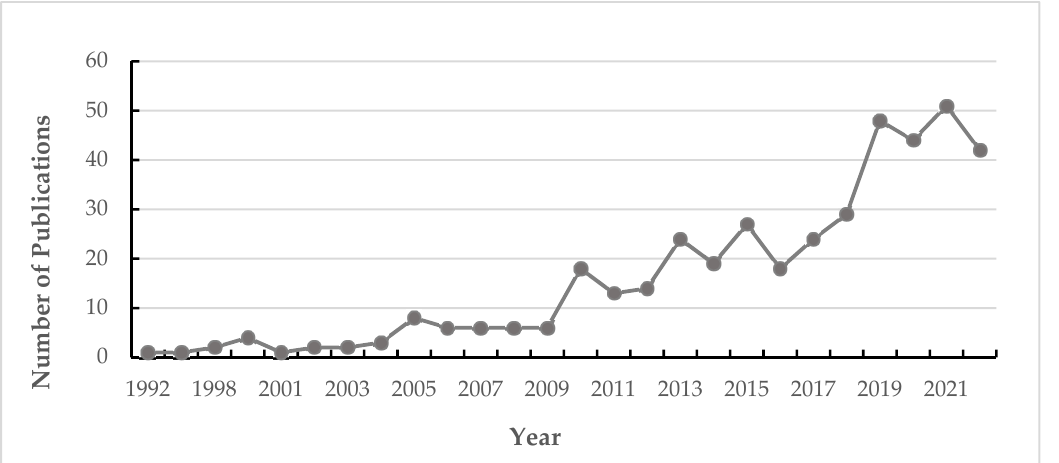
Figure 2. The number of papers published in the field of agrobiodiversity and traditional knowledge from 1992 to mid-2022.